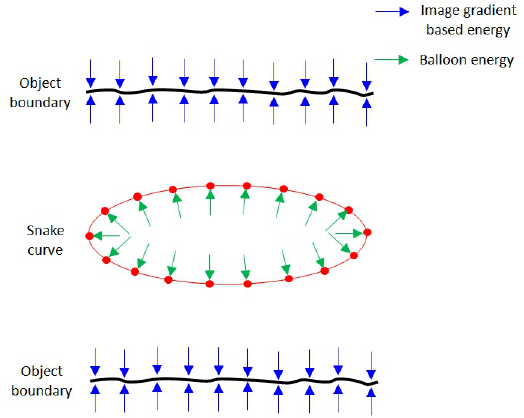
Figure 4. Balloon external energy added to the snake